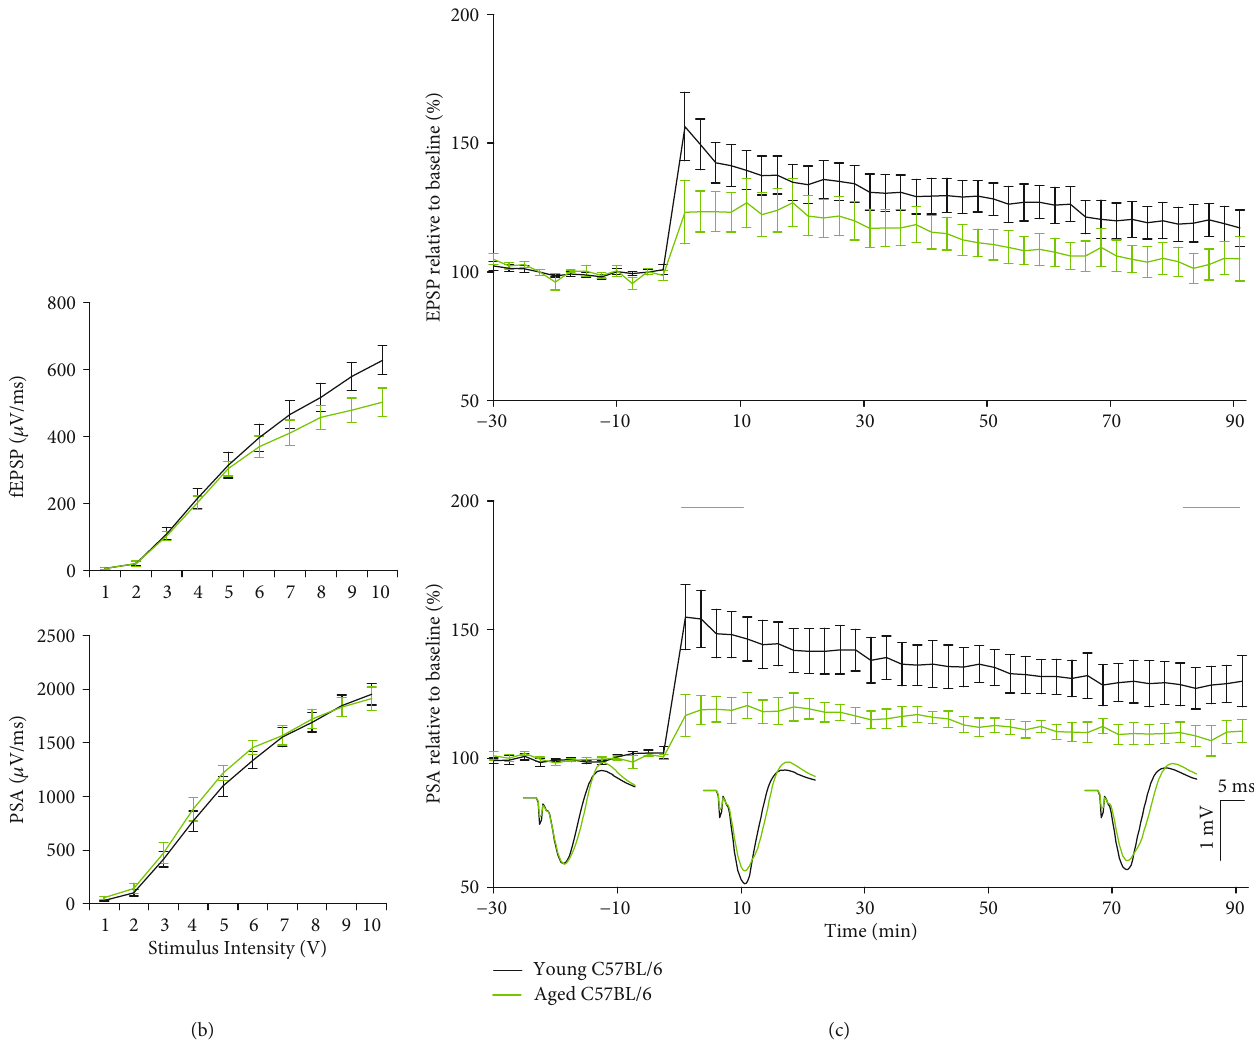
Figure 5: (a) Placement of the stimulation-recording electrodes at the Scha ff er collateral-CA1 stratum pyramidal synapses in anesthetized mice (top panel), and a typical waveform spaghetti curves where the latency to peak negative de fl ection of fEPSPs is within 6-10ms and the maximum amplitude between 1500 μ V and 2500 μ V. (b) Collective I/O curves of stimulation voltage and fEPSP slope (top panel) or PSA (bottom panel) values relative to baseline are plotted for young (black, n = 9 ) and aged (green n = 8 ) C57BL/6 mice. There was no signi fi cant alteration in baseline synaptic response, (c) A decline in synaptic response to HFS was observed in normalized EPSP and PSA values and was maintained throughout the recording session. No di ff erence was observed in the average wave form during the 30 min baseline interval prior tetanisation, whereas smaller waveform was observed in aged mice during 0-30min and 60-90 min posttetanisation. Data are presented as means ± SEM (%). Line above indicates statistical signi fi cance between groups, repeated